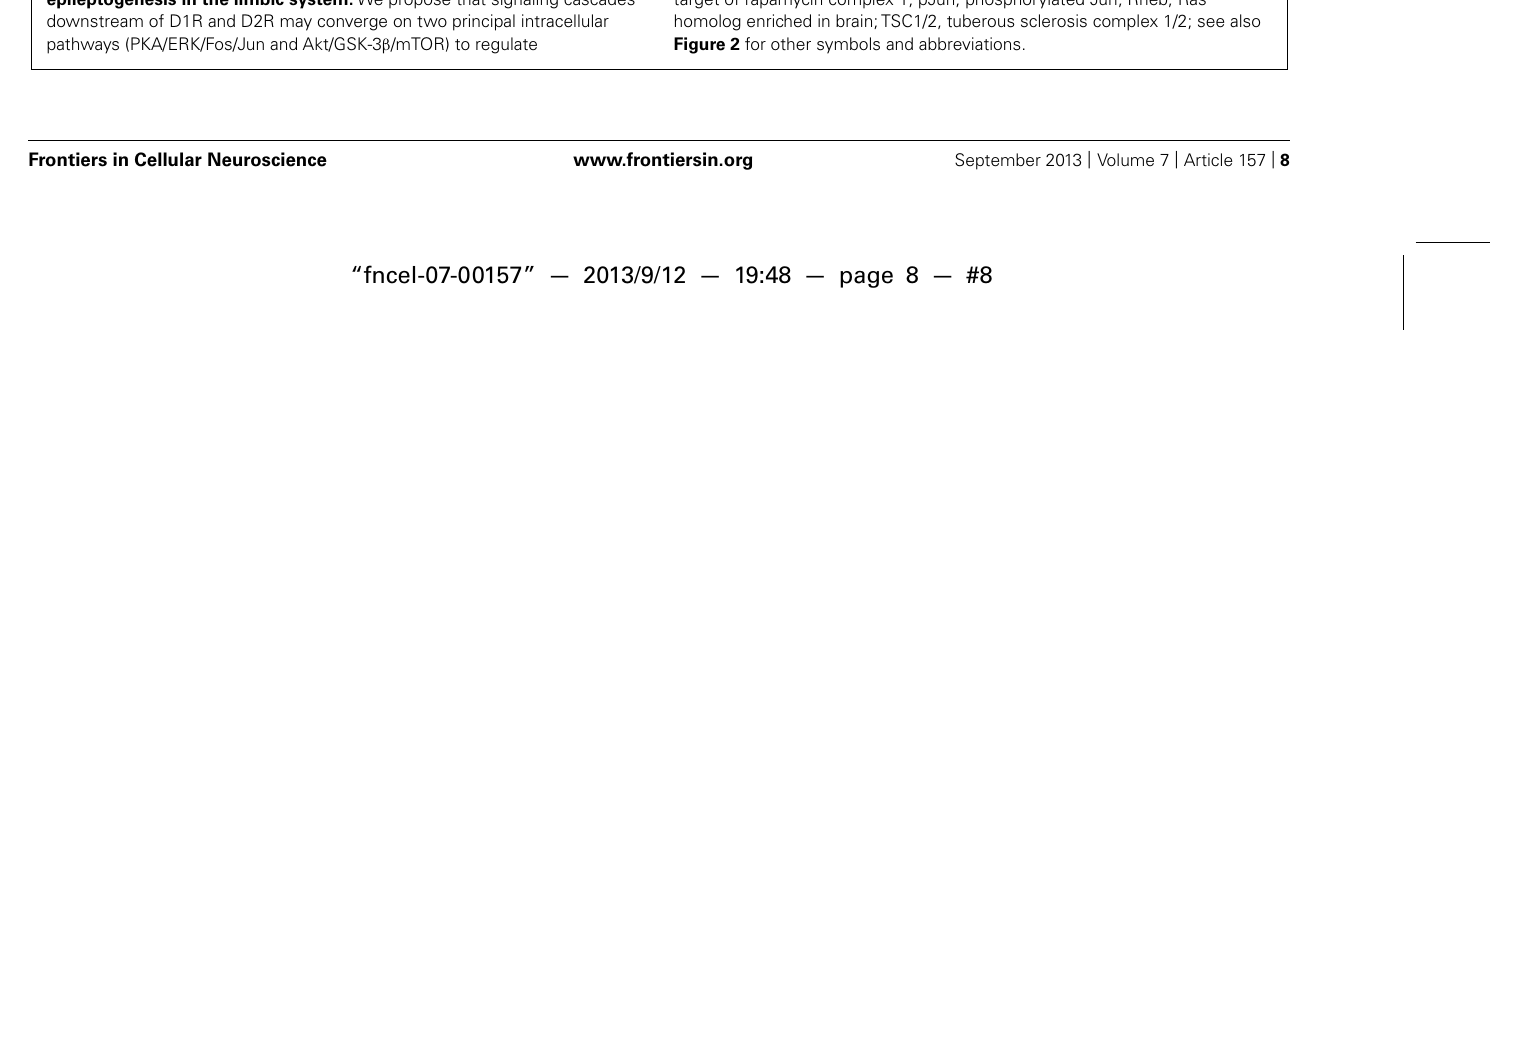
seizure-induced cell death and epileptogenesis. See text for details. α olf β 2 γ 7 , trimeric G olf protein; elF4E, elongation factor 4E; mTORC1, mammalian target of rapamycin complex 1; pJun, phosphorylated Jun; Rheb, Ras homolog enriched in brain;TSC1/2, tuberous sclerosis complex 1/2; see also Figure 2 for other symbols and